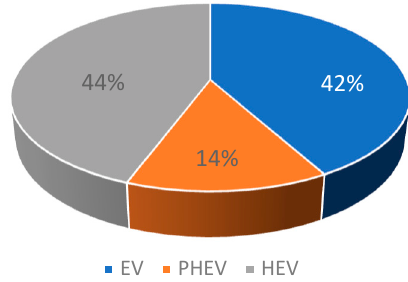
Figure 2. Types of registered EVs in 2022.